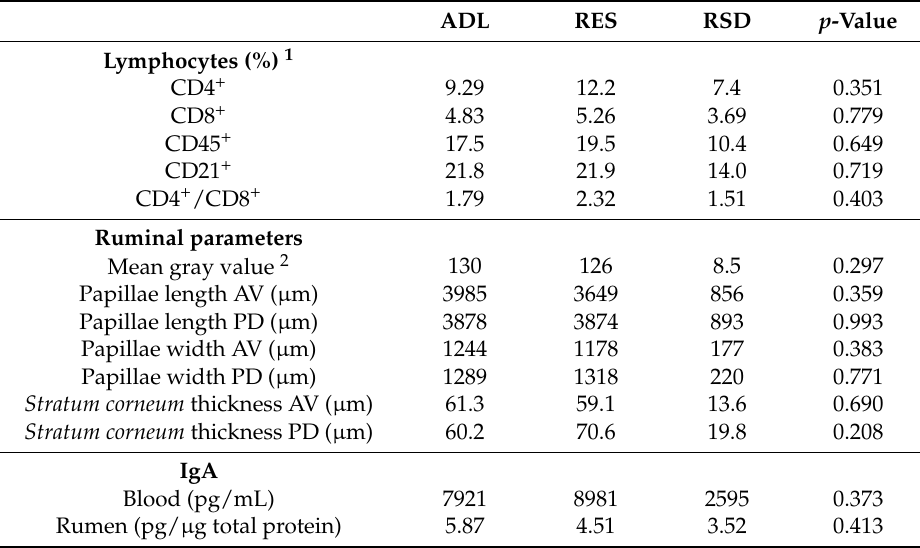
Table 2. Lymphocyte counts measured by flow cytometry in peripheral blood, ruminal parameters, and immunoglobulin A (IgA) concentration in serum and ruminal mucosa of fattening lambs being fed ad libitum (ADL) or restricted (RES) diets during the suckling